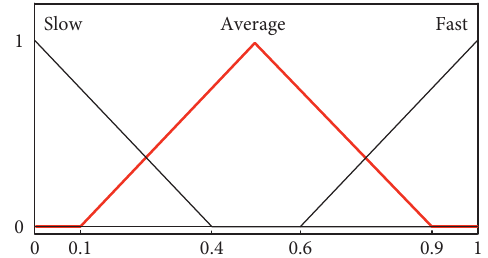
Figure 17: FV membership functions for LV a acceleration”.